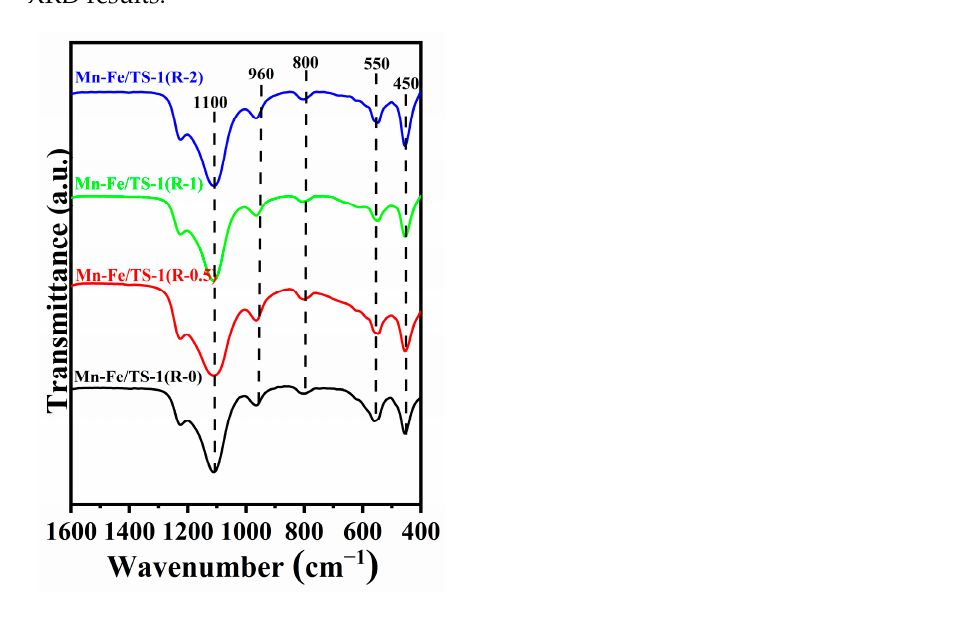
Figure 2. FT − IR spectra of Mn–Fe/TS-1(R-0), Mn–Fe/TS-1(R-0.5), Mn–Fe/TS-1(R-1), and Mn–Fe/TS-1(R-2).